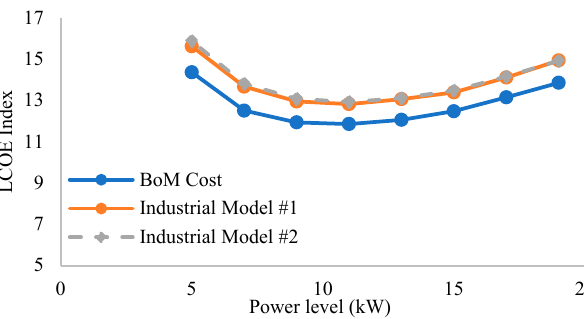
Figure 23. LCOE index for different cost models (Grenoble).